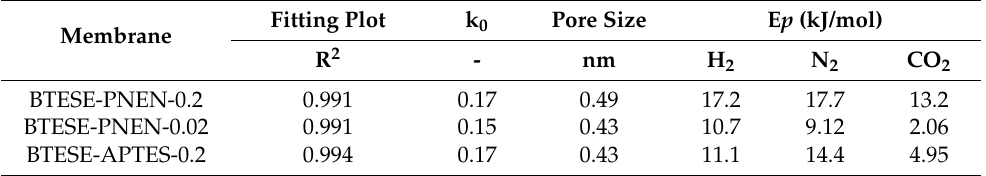
Table 5. Pore size and apparent activation energy based on modified GT model.